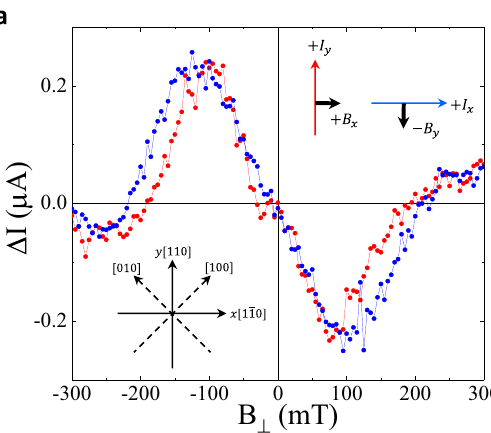
Bracketswitharrowsindicateamaximum Δ B neededtoinserta fl ux ϕ 0 = h /2 e inthe area de fi ned by the corresponding wire lengths, as indicated by a dashed loop in the inset. An effective length for the period marked by a magenta bracket is l =0.5 μ m for the same